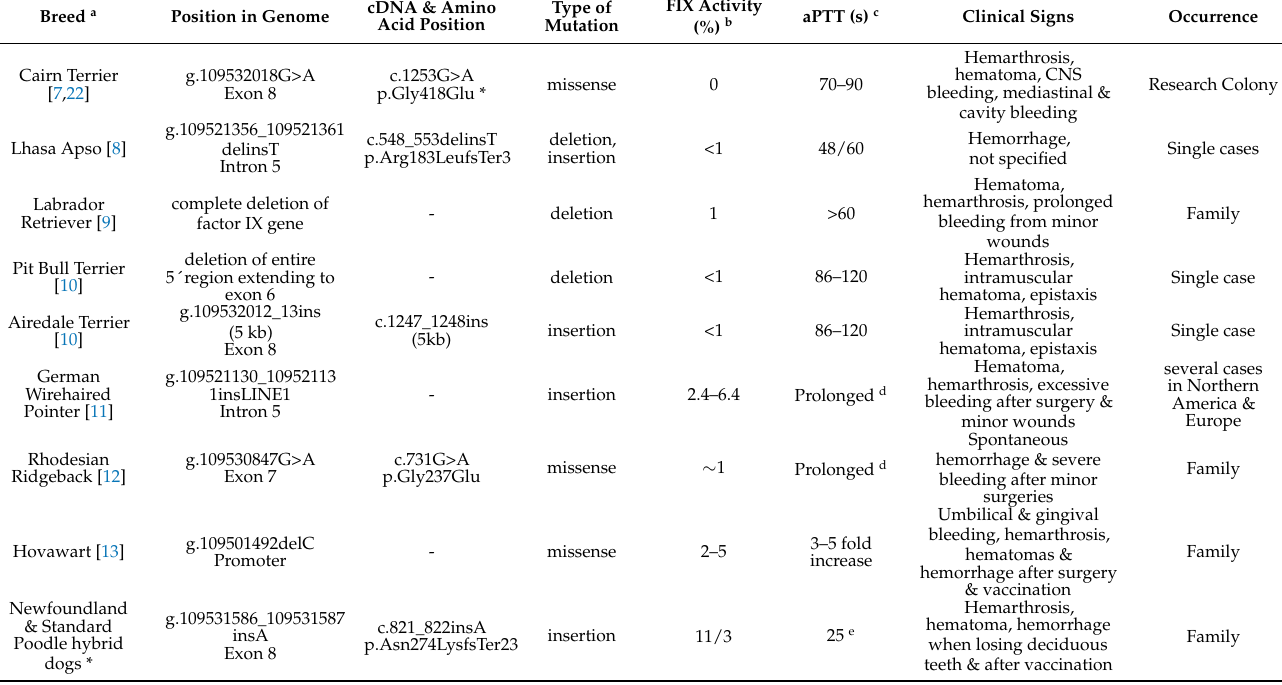
Table 3. Characteristics of hemophilia B in dogs with known F9 variants associated with hemophilia B in